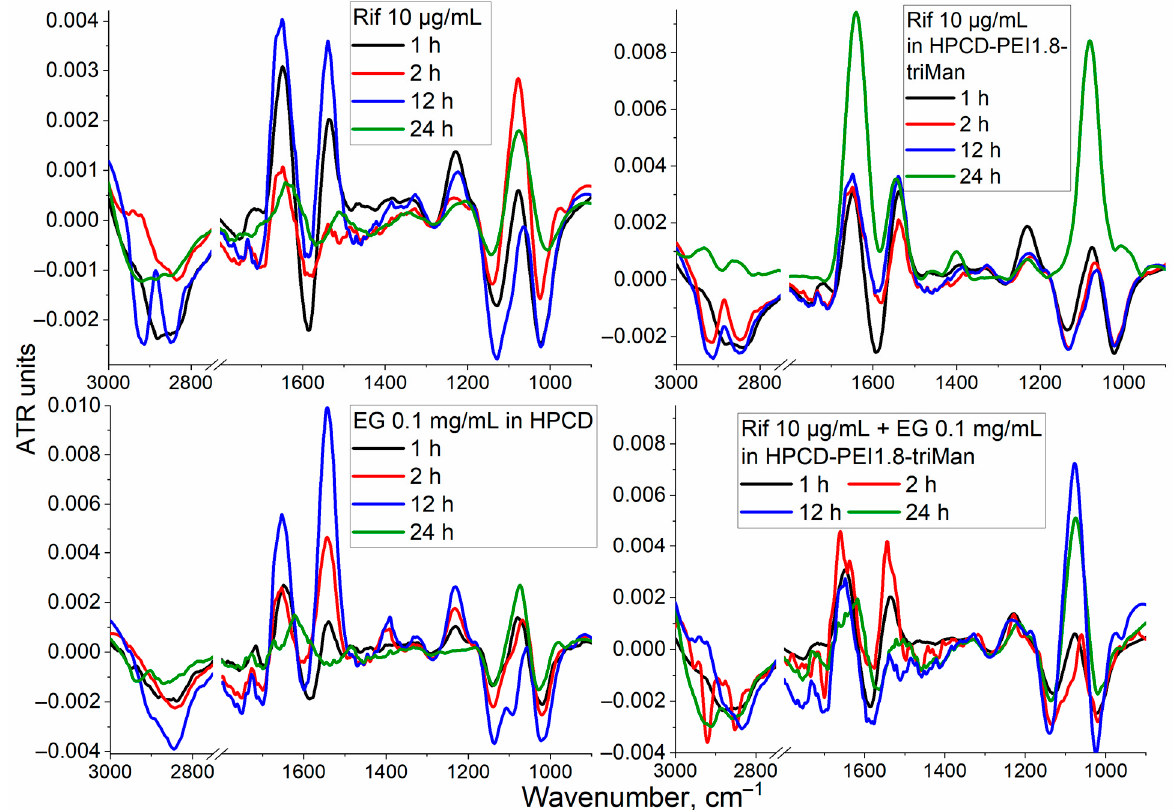
Figure 2. Difference FTIR spectra of E. coli incubated with rifampicin (Rif) or/and eugenol (EG) drug formulations. The spectra at the zero moment of time are subtracted. T = 22 °C.